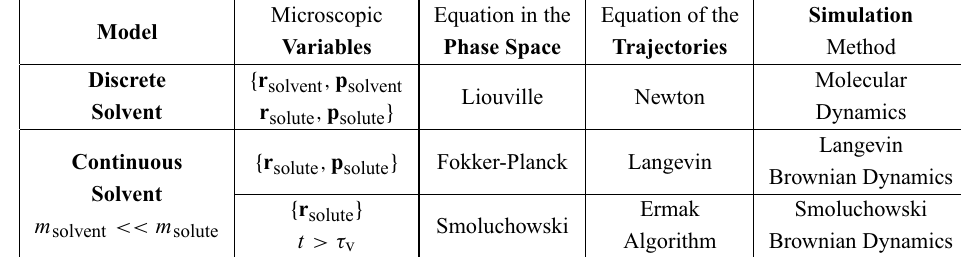
Fig. 2 – Left: Cation (Na + ) distribution between two montmorillonite clay layers. Solid line: molecular dynamics. Dashed line: Poisson-Boltzmann equation. Right: Electro-osmotic flux. Diamonds: molecular dynamics. Dashed line: Navier-Stokes equation with stick boundary condition. Solid line: Navier-Stokes equation with slip boundary conditions ( δ = 6 Å).